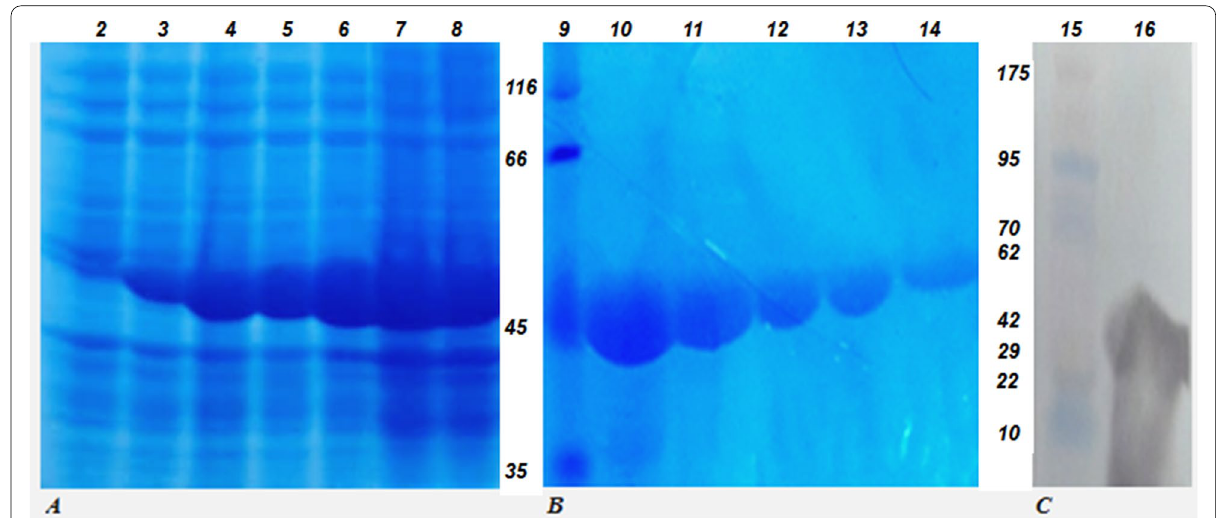
Fig. 3 Expression, purification, and western blotting of chimeric PvpA-pMGA protein. A Electrophoresis of cell lysate of chimeric protein in SDS-PAGE 10% which was induced in different times; Lane 2: cell-lysated from before induction, lanes 3 to 8 are cell-lysated 1 to 16 h after induction. B Electrophoresis of purified recombinant protein. 9: Unstained protein MW marker (Thermo Scientific), lanes 10 to 14 are elutions 1 to 5. C Western blotting of recombinant protein by HRP conjugated anti-His tag antibody in nitrocellulose membrane. Lane 15: prestained protein ladder. Lane 16: purified PvpA-pMGA detected by anti-His-tag antibody